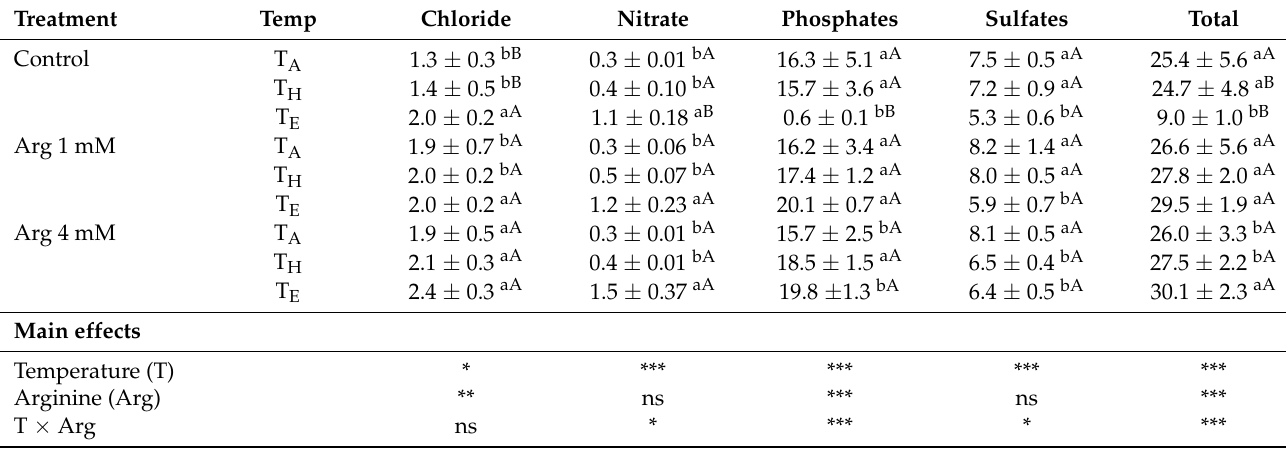
Table 3. Anion content (g kg − 1 DW) of cauliflower florets affected by short-term heat stress and foliar arginine application.